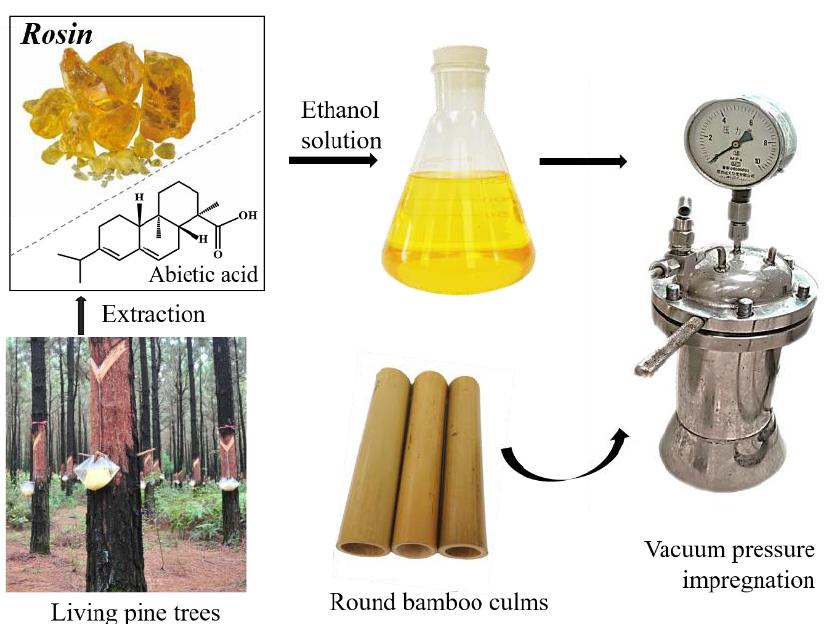
Figure 1. Schematic illustration of rosin impregnation of bamboo culms .